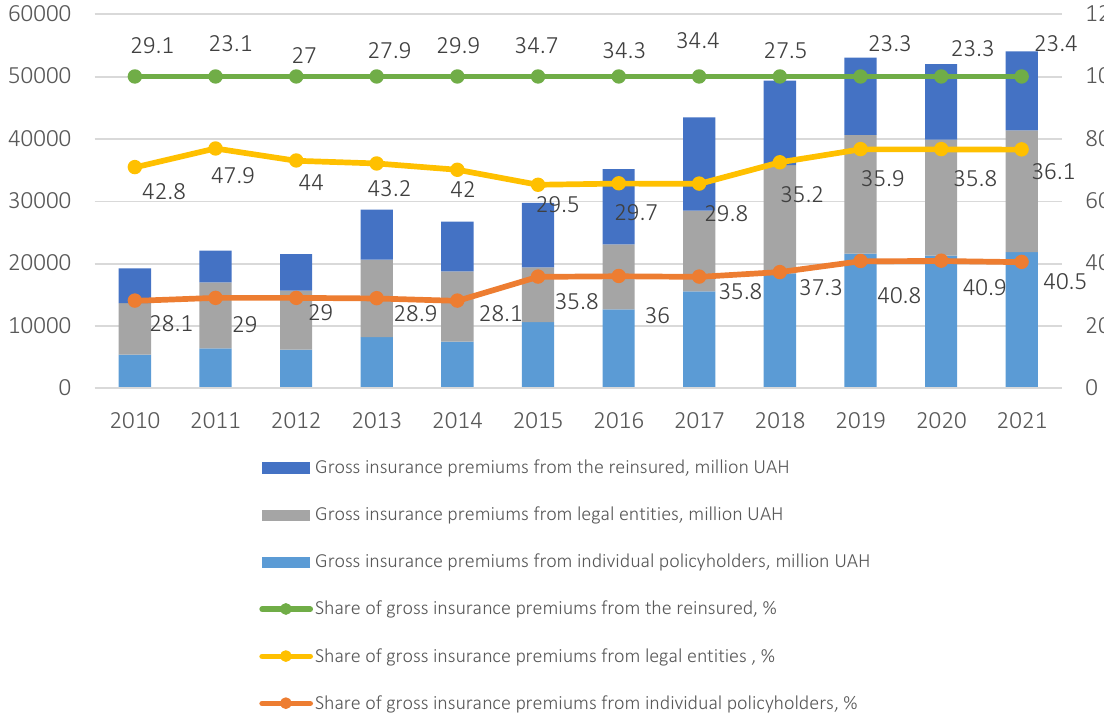
Figure 5. Volume and structure of income from gross insurance premiums in 2010–2021